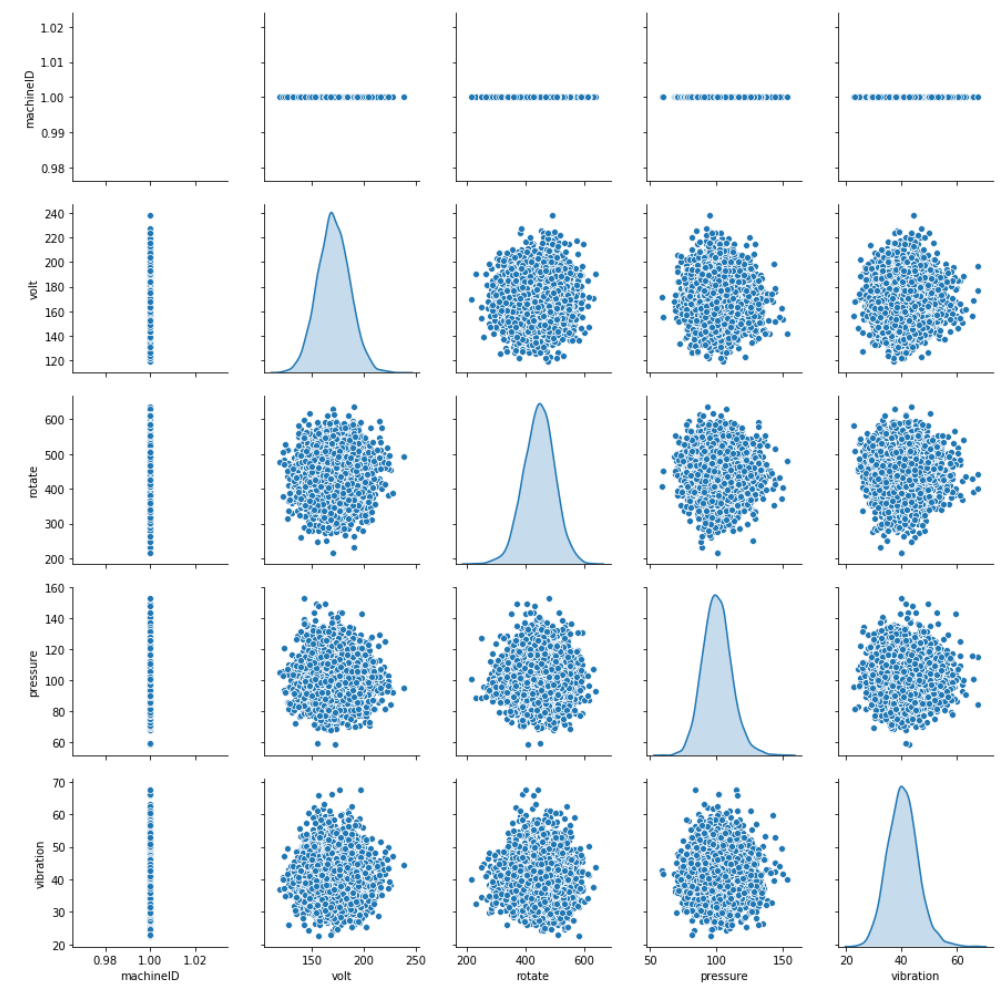
Figure 5. Distribution of the different machine features including